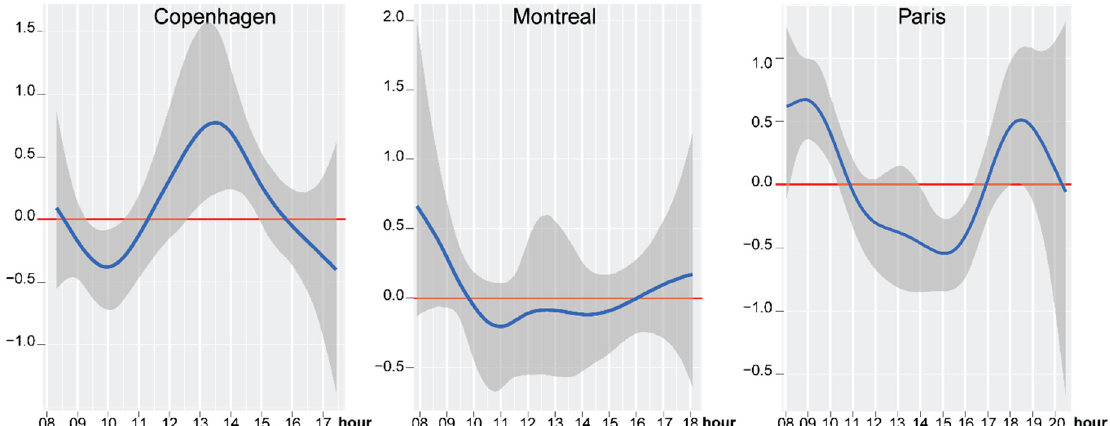
Figure 5. Marginal effects of time on noise exposure prediction for the three cities. The red horizontal line represents the daily mean and allows us to observe when the exposure values are higher and lower during the day, all other things being equal.